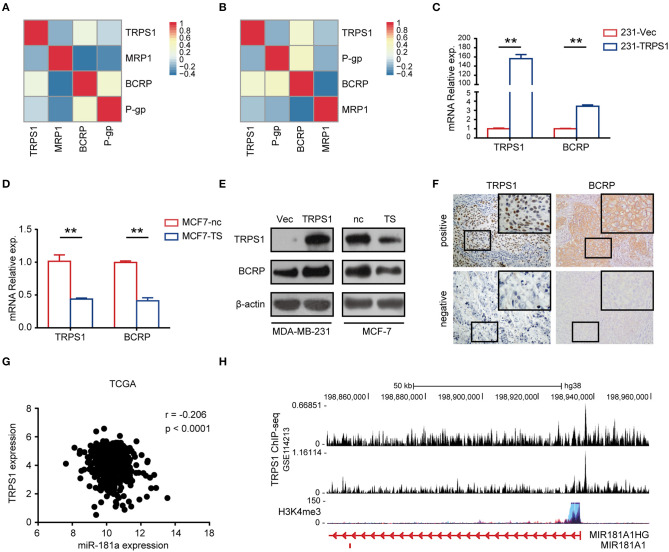
TRPS1 regulated BCRP expression. (A,B) Correlation of TRPS1 and ABC transporters in R2 database (A) and GSE27830 (B). (C,D) qRT-PCR analyses of TRPS1 and BCRP mRNA expression of indicated cells (C, 231-Vec/231-TRPS1; D, MCF7-nc/MCF7-TS). (E) Western blots analyses of TRPS1 and BCRP protein expression of indicated BCa cell lines transfected with nc/TS or Vec/TRPS1. (F) Representative images of IHC staining of TRPS1 and BCRP in BCa patients. (G) Correlation of TRPS1 and miR-181a in TCGA data. (H) Enrichment of TRPS1 at miR-181a promotor region determined by ChIP-seq experiment (GSE114213). **P < 0.01.